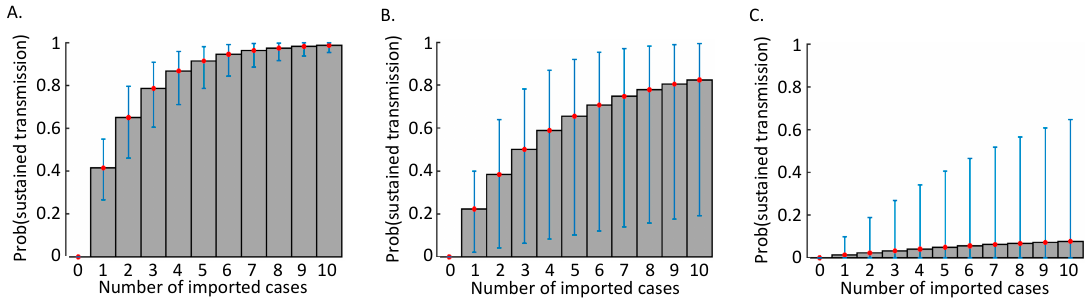
Figure 2. The probability of a self-sustaining outbreak driven by human-to-human transmission arising from multiple independent cases imported to a new location, under different surveillance levels. ( A ) No intensification of surveillance ( 𝜌 = 0 ). ( B ) Medium level of surveillance intensification ( 𝜌 = 0.25 ). ( C ) High level of surveillance intensification ( 𝜌 = 0.5 ). The grey bars and red dots show the mean estimates (obtained using Equation (4)), and the error bars indicate the 5th and 95th percentile estimates obtained when Equation (3) is applied.